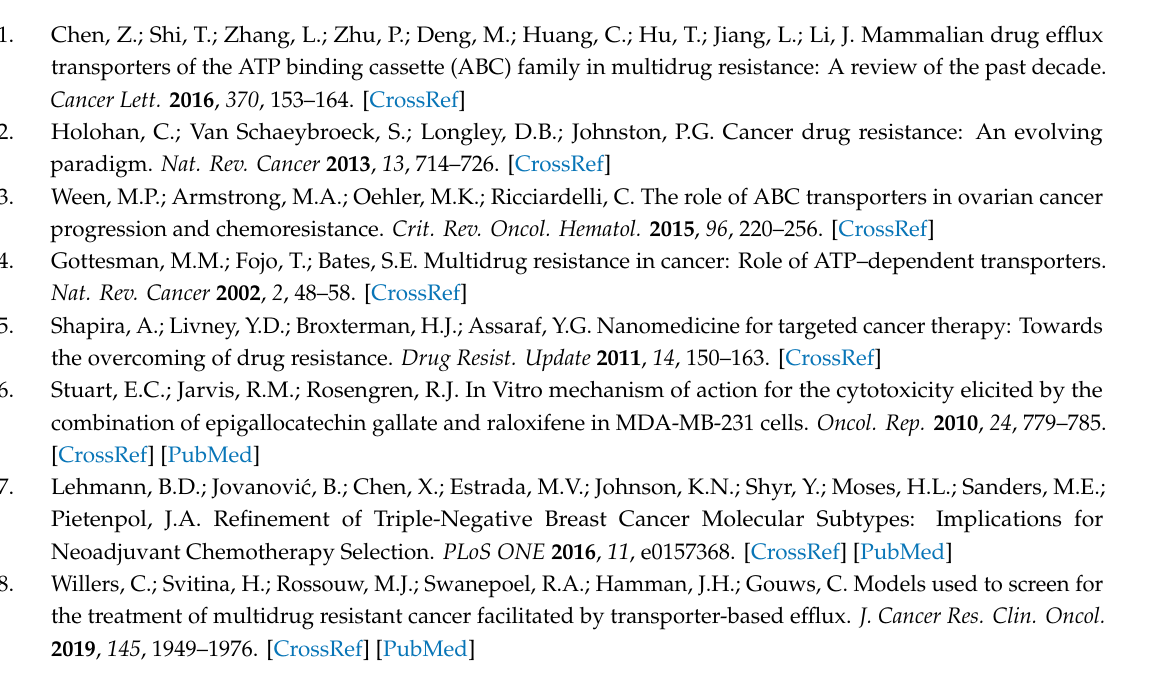
Figure S1: Expression of Pgp, MRP1 and BCRP in the cell lines analyzed, Figure S2: Dose-dependent cytotoxicity of blank SLNs, Figure S3: E ff ects of CURC-loaded SLNs co-incubated with rhodamine 123 on the dye retention, Figure S4: E ff ects of CURC-loaded SLNs on MRP1 and BCRP expression, Figure S5: E ff ect of CURC-loaded SLNs on HIF-1 α activation, Figure S6: E ff ect of CURC-loaded SLNs on c-Rel